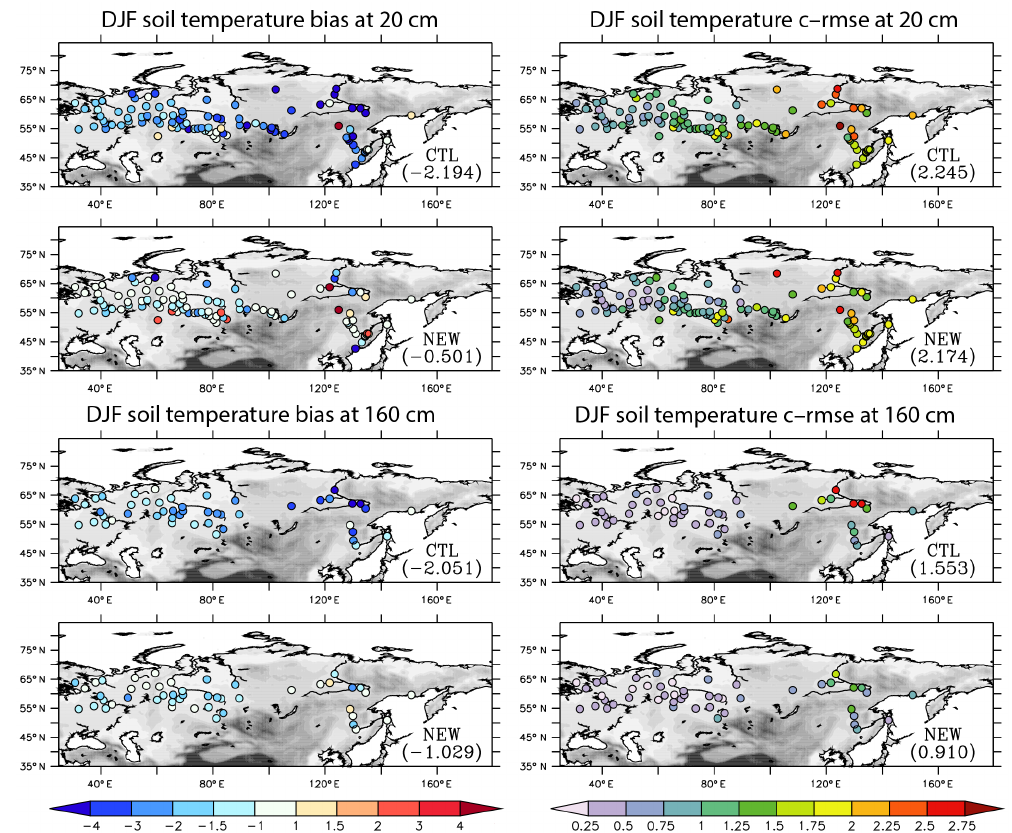
Figure 10. Monthly soil temperature skill scores at 20 and 160cm depths simulated by the CTL and the NEW experiments during winter and expressed in degrees Celsius. Total scores (bias and c-rmse) are given for each